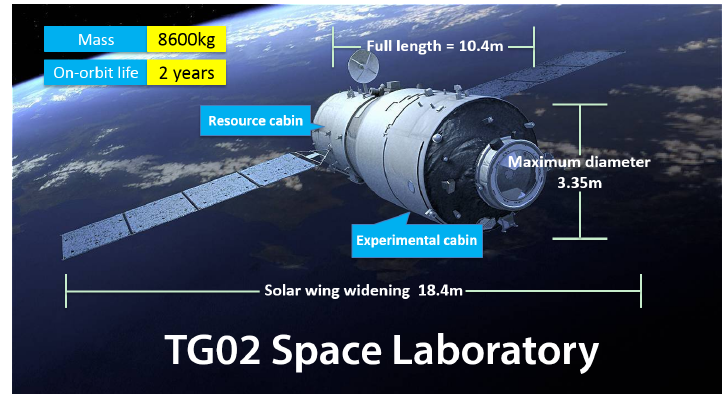
Figure 1. TG02 Spacelab and its main